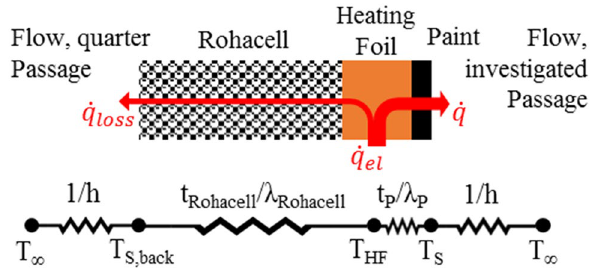
Fig. 8 Simplified heat resistance network of the